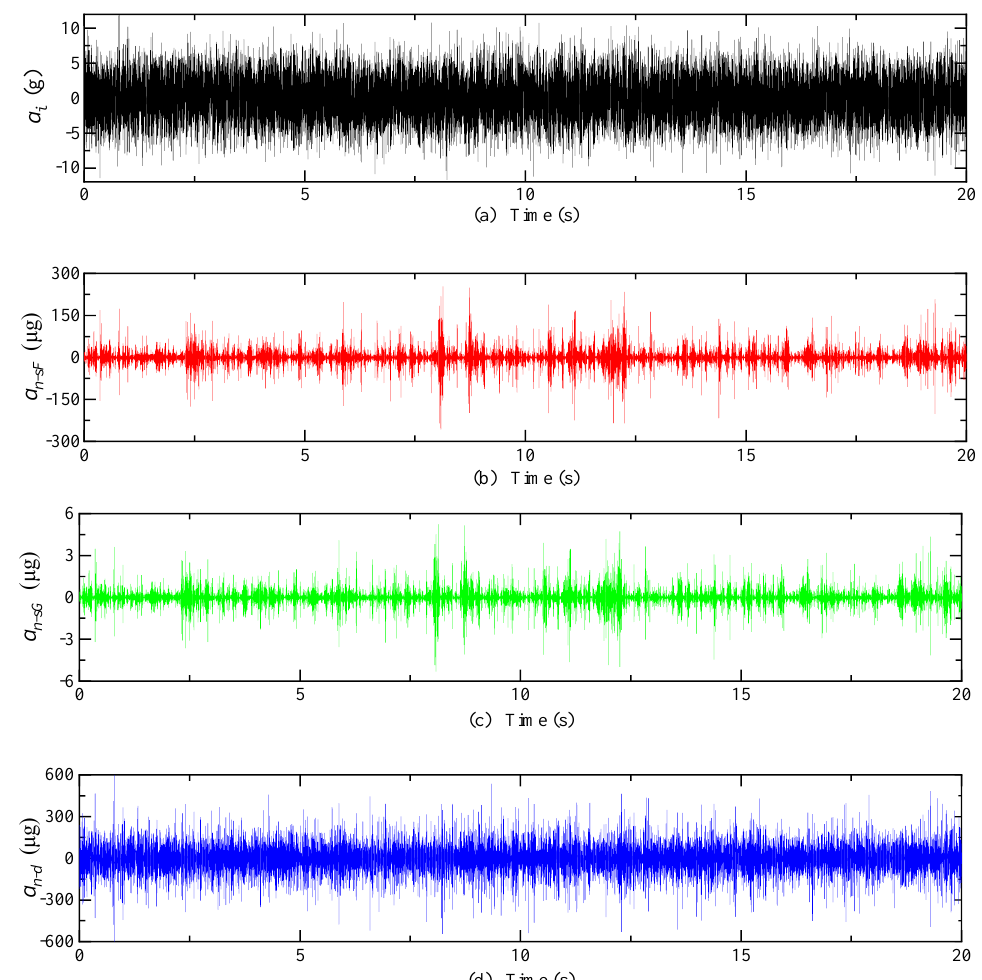
Figure 9. Electric field coupling detection noise simulation results. ( a ) Input acceleration; ( b ) The detection noise equivalent acceleration of the SCM detection circuit when the float shell is used; ( c ) The detection noise equivalent acceleration of the SCM detection circuit when the shell is grounded; ( d ) The detection noise equivalent acceleration of the DCM detection circuit.